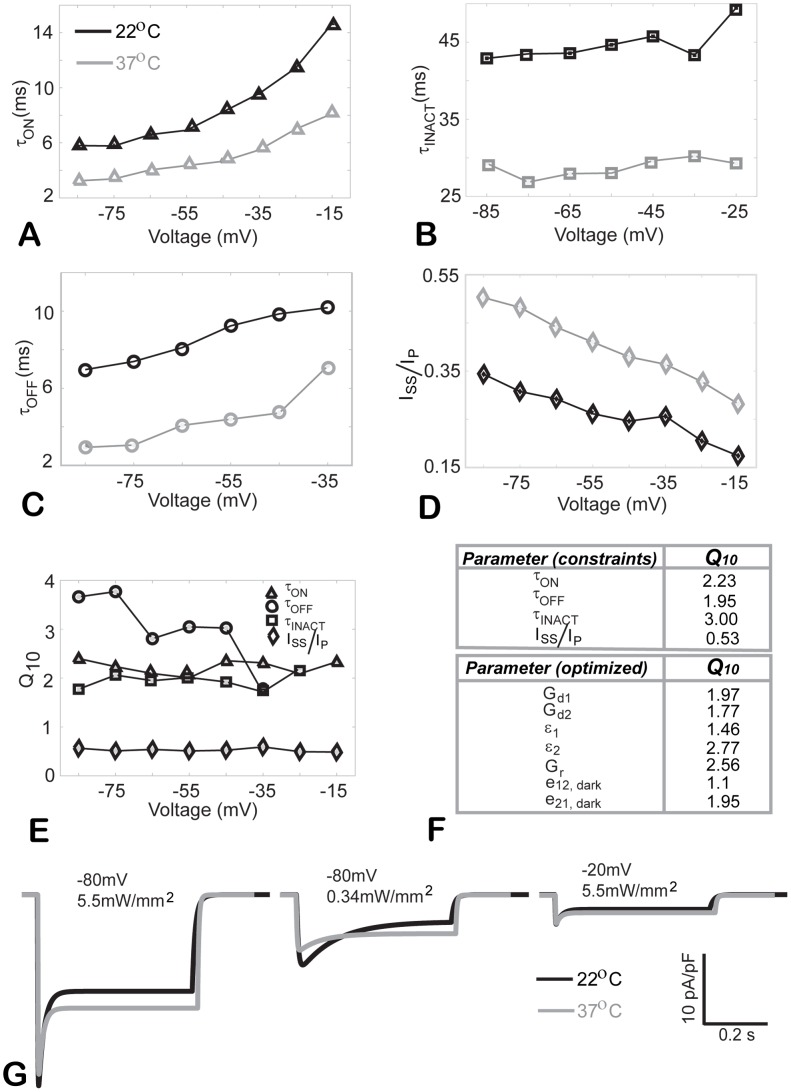
Temperature dependence of ChR2 current.
A–D Experimental data, adapted from [30], showing the effect of temperature (22°C and 37°C) on τON, τINACT, τOFF and ISS/IP for a range of voltages. E. Temperature scaling factors (Q10 values), derived from the data in A–D. F. Summary of average Q10 values (from E) used as constraints for the model optimization; optimized Q10 values for the rate parameters of the model. G. Example model traces of ChR2 current for the specified voltage and irradiance values at 22°C and 37°C.